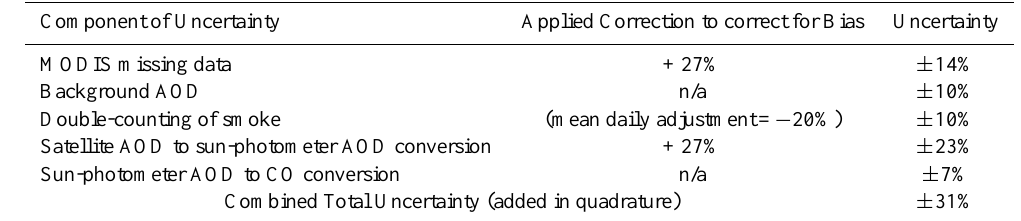
Table 1. Biases and uncertainties in the method for estimating emissions of CO from the Canberra fires. Component of Uncertainty Applied Correction to correct for Bias Uncertainty MODIS missing data + 27% ± 14% Background AOD Double-counting of smoke Satellite AOD to sun-photometer AOD conversion Sun-photometer AOD to CO conversion n/a ± 7% Combined Total Uncertainty (added in